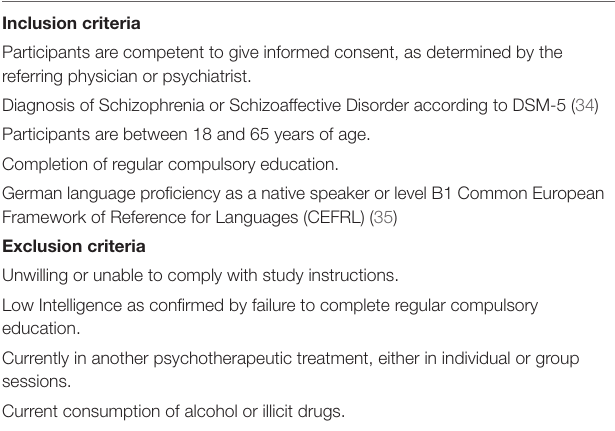
TABLE 1 | Inclusion and Exclusion criteria. Inclusion